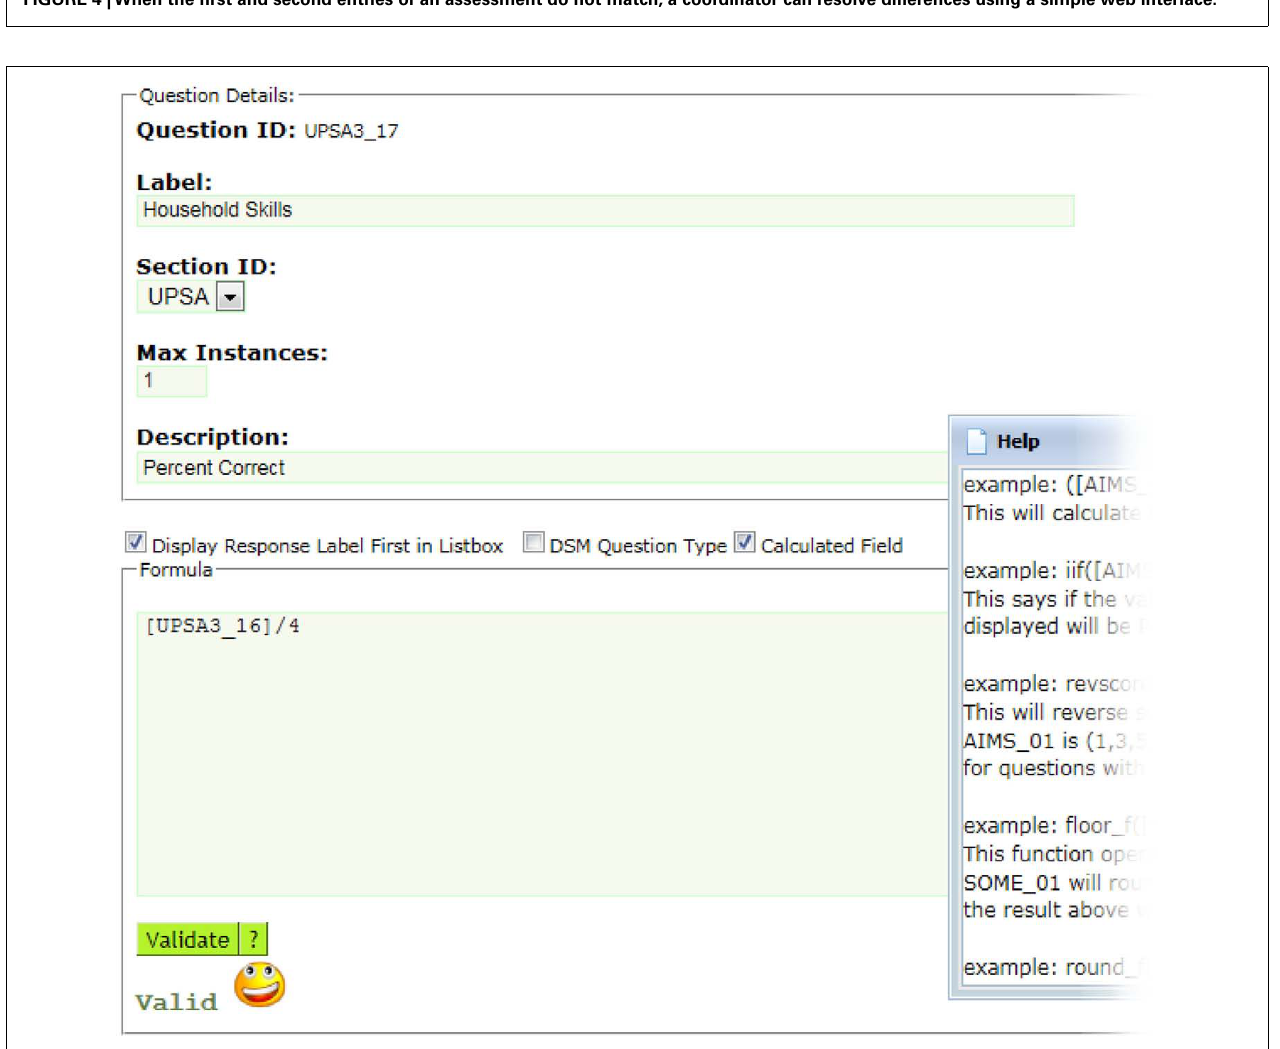
id, UPSA3_16 by 4. If you wanted to make this question id UPSA3_17 equal to UPSA3_16 reverse scored, the formula would be as simple as revscore ([UPSA3_16]).